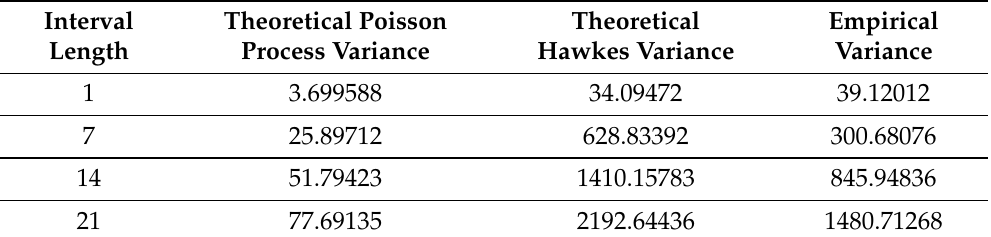
Table 4. Comparison of Theoretical Variance of Poisson Process and Hawkes Process vs Empirical Variance for Different Interval Length Time in Days of Group